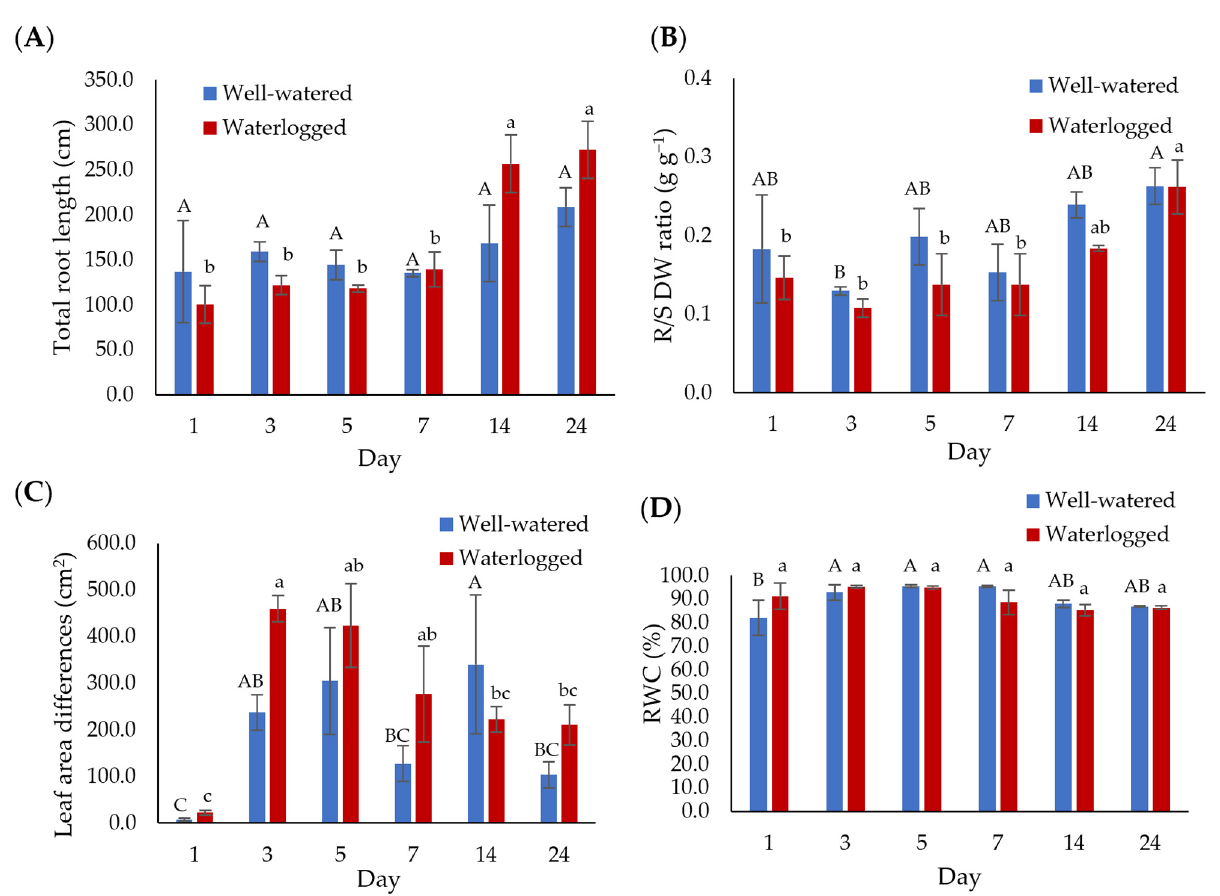
Figure 1. The growth of well-watered and waterlogged banana plants was measured in terms of ( A ) total root length, ( B ) root-to-shoot (R/S) dry weight (DW) ratio, and ( C ) leaf area differences. ( D ) The effect of waterlogging on relative water content (RWC) was assessed between well-watered and waterlogged leaf samples. Data are presented as means ± standard error from nine independent biological replicates. Different capital letters indicate a significant difference between time points within well-watered samples, while different lowercase letters indicate a significant difference between time points within waterlogged samples ( p < 0.05).